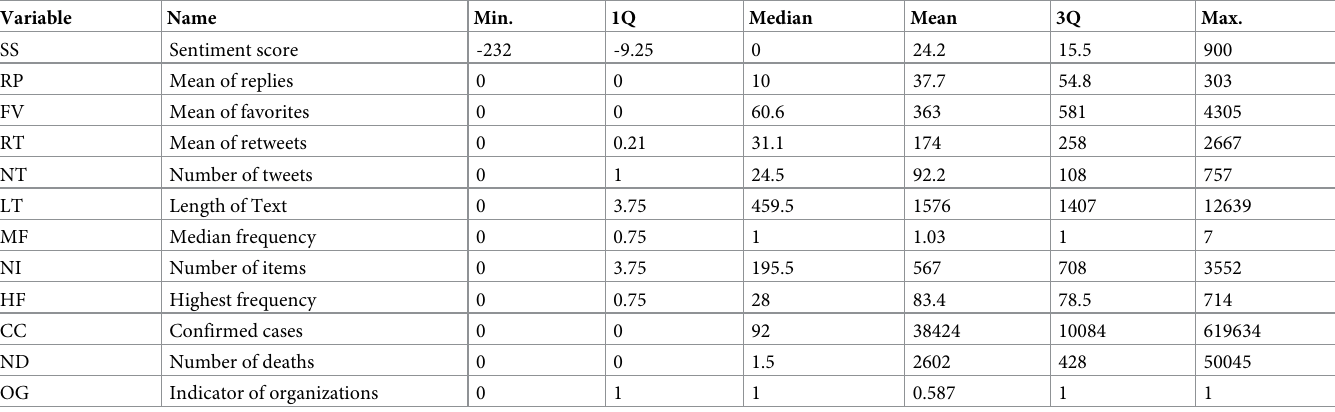
Note: Q: quarter. The aggregated data has 216 (= 9 � 24) rows. Each row represent the statistics of an organization’s weekly tweets or cases. The 24 weeks are